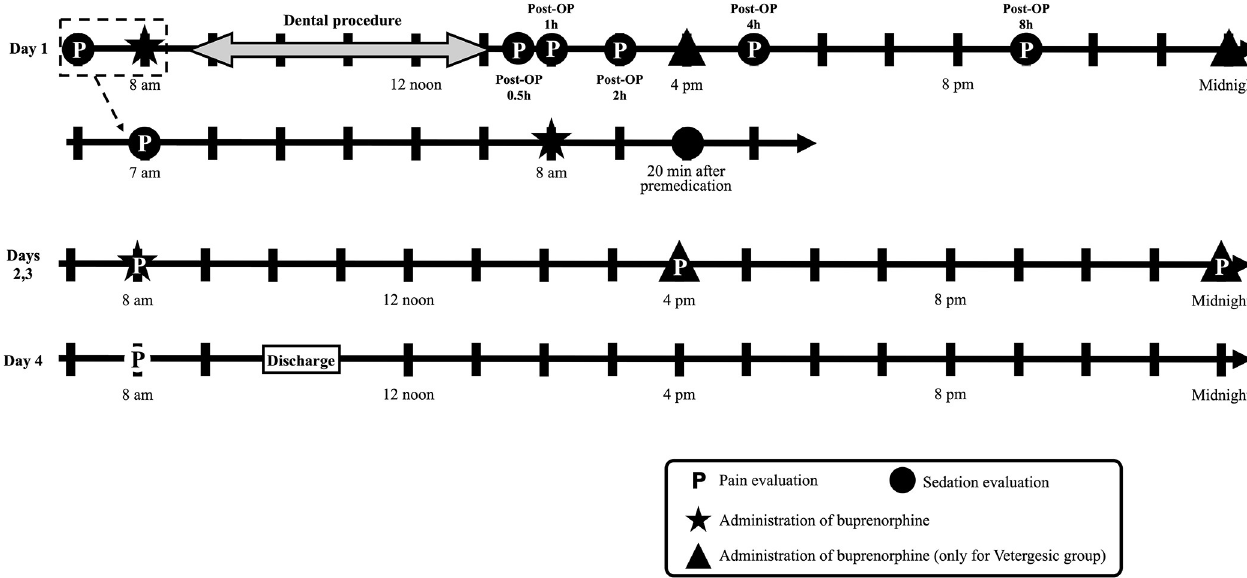
Fig 1. Schematic of time points for administration of buprenorphine during the study. The timeline demonstrates and example of a 4-hour dental procedure in a cat including time points of pain and sedation assessment.